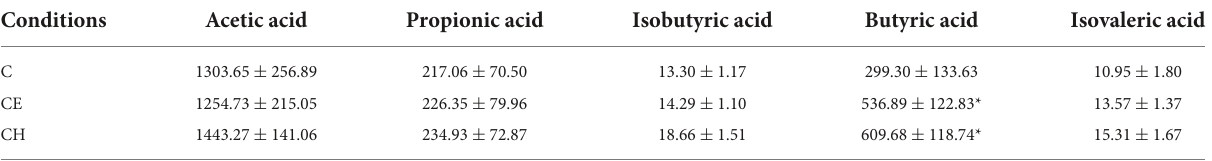
TABLE 3 Short-chain fatty acids (SCFAs) levels in the colonic content.